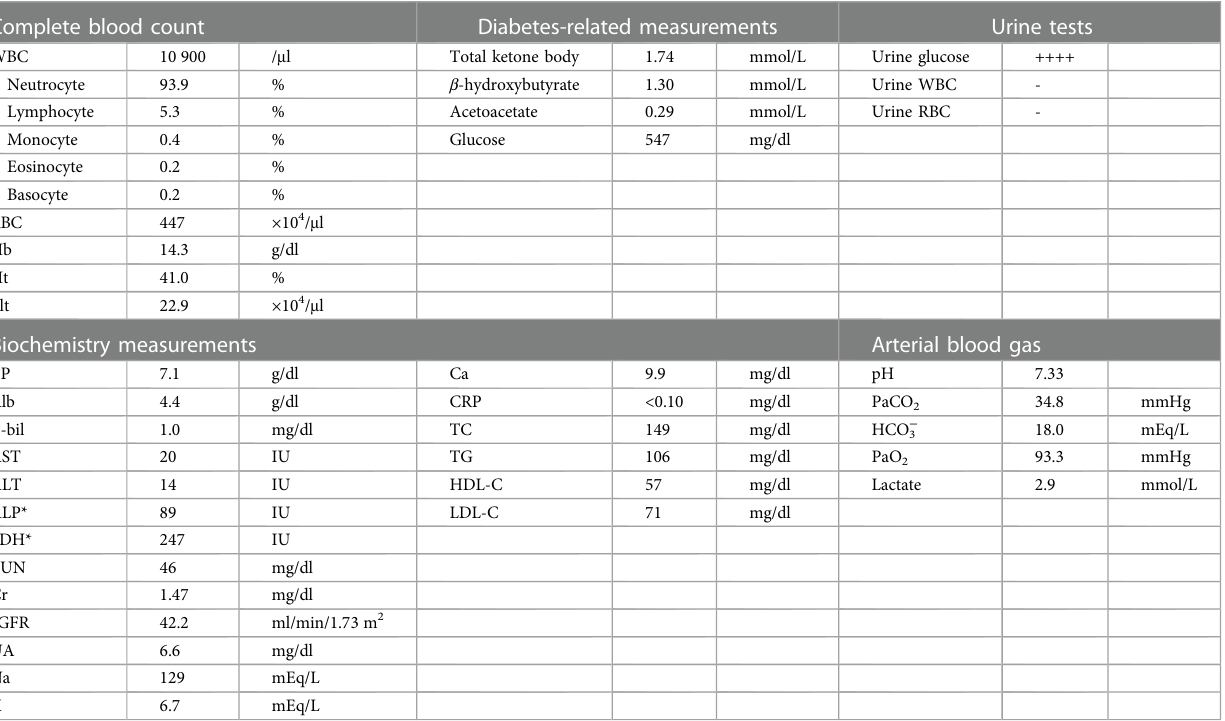
TABLE 2 Laboratory fi ndings at the onset of DKA.